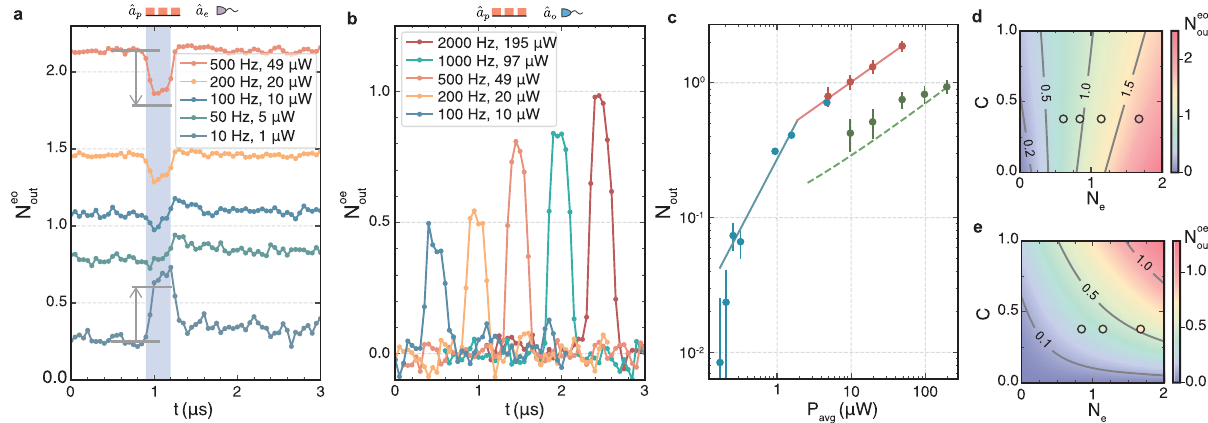
for a 300 ns-long optical pump pulse ( C = 0.38) for different repetition rates f rep ( P avg ) measured Fig. 3 Measured added noise during conversion. a N e out with a 10 MHz bandwidth centered at the microwave resonance. The blue-shaded region shows the time span when the optical pump is on. The gray arrows mark the noise change as predicted from theory. b N o for the same optical pump pulses and various f rep ( P avg ) measured with a 10 MHz bandwidth out centered at the optical signal frequency. The noise pulses are separated in time for better visibility. c Compilation of all measured N out for different time- averaged optical pump powers P avg . Red and blue points represent measured N e with 10 MHz and 100 kHz bandwidths, respectively. Green points out represent N o measured with 10 MHz bandwidth. The solid lines represent power-law fi ts. The green dashed line shows the predicted N o using the out out measured N e . All the points are taken with C = 0.38 ( η tot = 11.4%) except for the fi rst three blue points which correspond to C = 0.20 ( η tot = 8.0%), 0.24 out ( η tot = 9.1%), and 0.3 ( η tot = 10.3%), respectively. The error bars are inferred as in ref. 14 . For low occupancies, the con fi dence interval is given by the systematic error due to the absolute drift of the measurement baseline of ± 0.02 photons. d Density plot of the calculated N e (10 MHz bandwidth) as a out function of C and N e for S ¼ 0 : 22. The top four measurements of N e for the same S taken from a are shown as circles with experimental values out represented by the inside color. e Density plot of the calculated N o (10 MHz bandwidth) as a function of C and N e for S ¼ 0 : 22. The left-most three out measurements from b are shown as circles where experimental values are represented by the inside